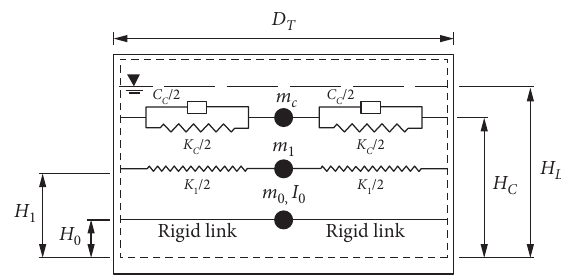
Figure 4: Mechanical analogy of the simplified liquid-tank system for a tank under combined translational and rocking